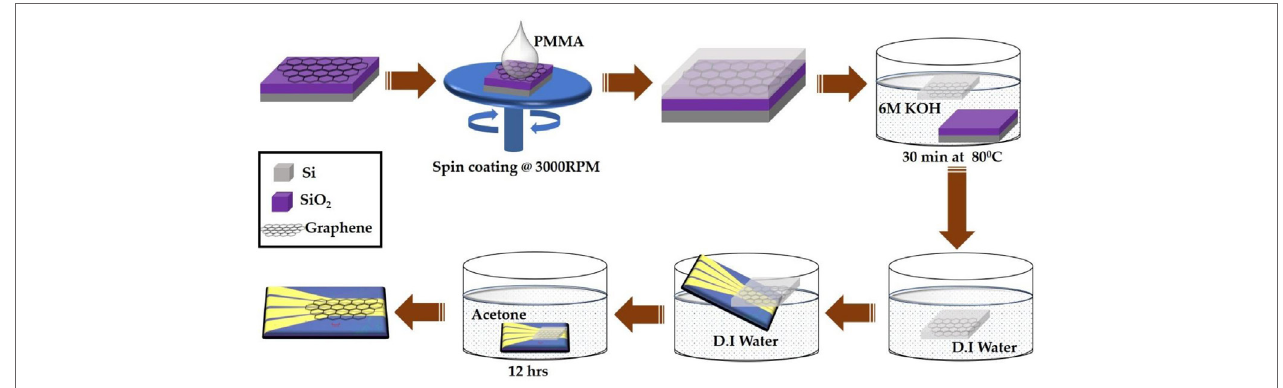
FigUre 2 | Schematic illustration of large area chemical vapor deposition-graphene field-effect transistor device fabrication